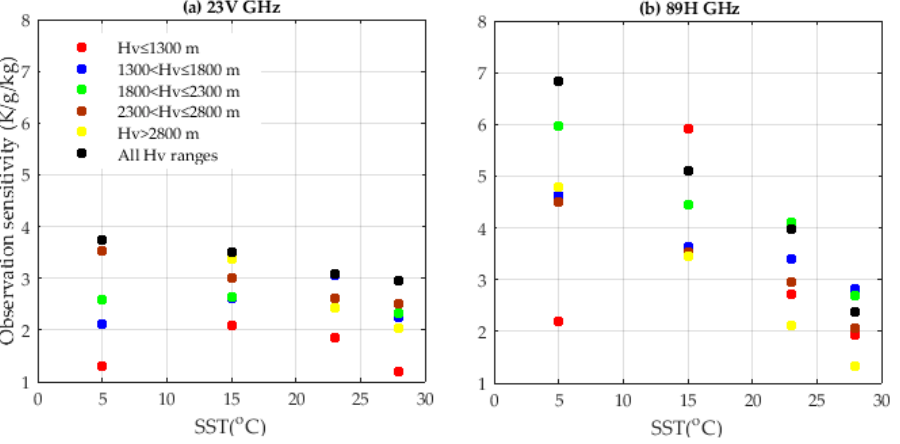
Figure 7. SST compared with observation sensitivity from a linear fitting for each SST range. ( a ) For 23 V GHz and ( b ) for 89 H GHz.